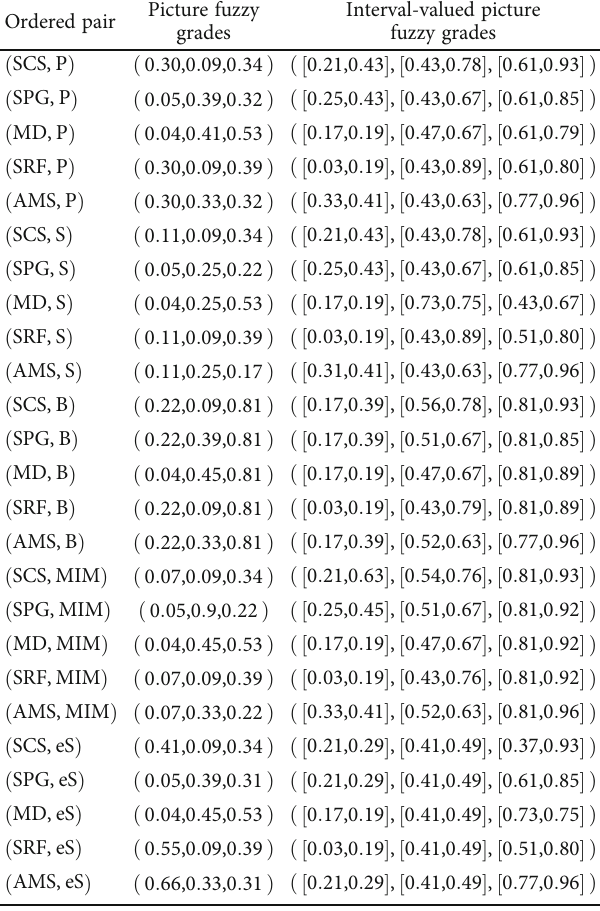
Table 4: Cartesian product I × J . Table 5: Cartesian product I × J .